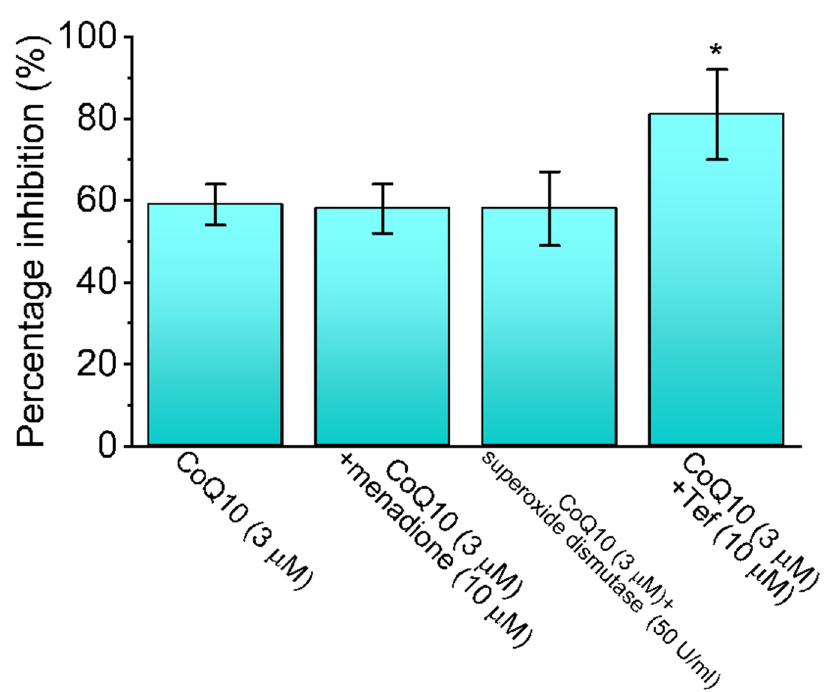
Figure 2. Summary bar graph showing effects (i.e., percentage inhibition) of ubiquinone (CoQ10), CoQ10 plus menadione, CoQ10 plus superoxide dismutase, and coQ10 plus tefluthrin (tef) (mean ± SEM; n = 8 for each bar). The results reflect that CoQ10 ‐ mediated inhibition of I Na is unlinked to the level of reactive oxygen species. Peak amplitudes of I Na with or without different tested compounds were compared. * Significantly different from CoQ10 (3 μ M) alone group ( p < 0.05).